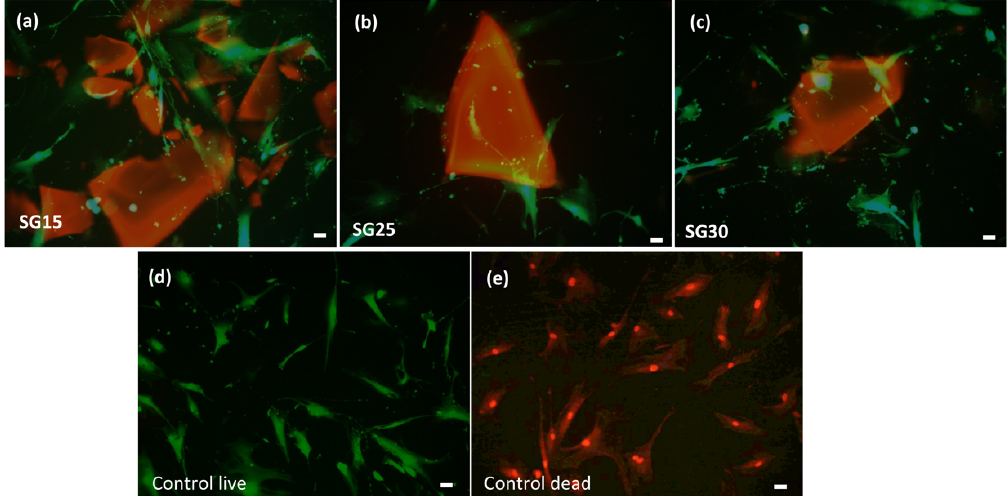
Figure 9. Live/dead staining of HOB ® cells after one week of culture, grown in the presence of SG15 ( a ), SG25 ( b ) and SG30 ( c ) aerogels. Live and dead controls showing cells growing without materials are shown in ( d ) and ( e), respectively. Images were acquired in the fluorescence and Nomarski modes using a Leica DMIL LED inverted microscope. Live cells appear green and the nuclei of dead cells are stained red. In the merged images, the aerogels appear soft red. Scale bar: 20 μ m.